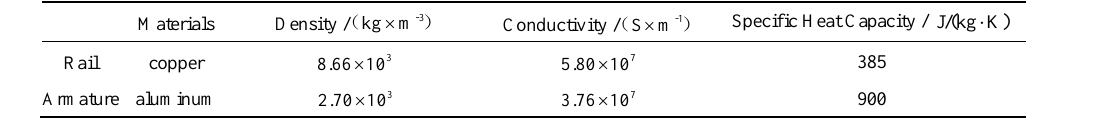
TABLE II. Electromagnetic launcher model parameters Parameters